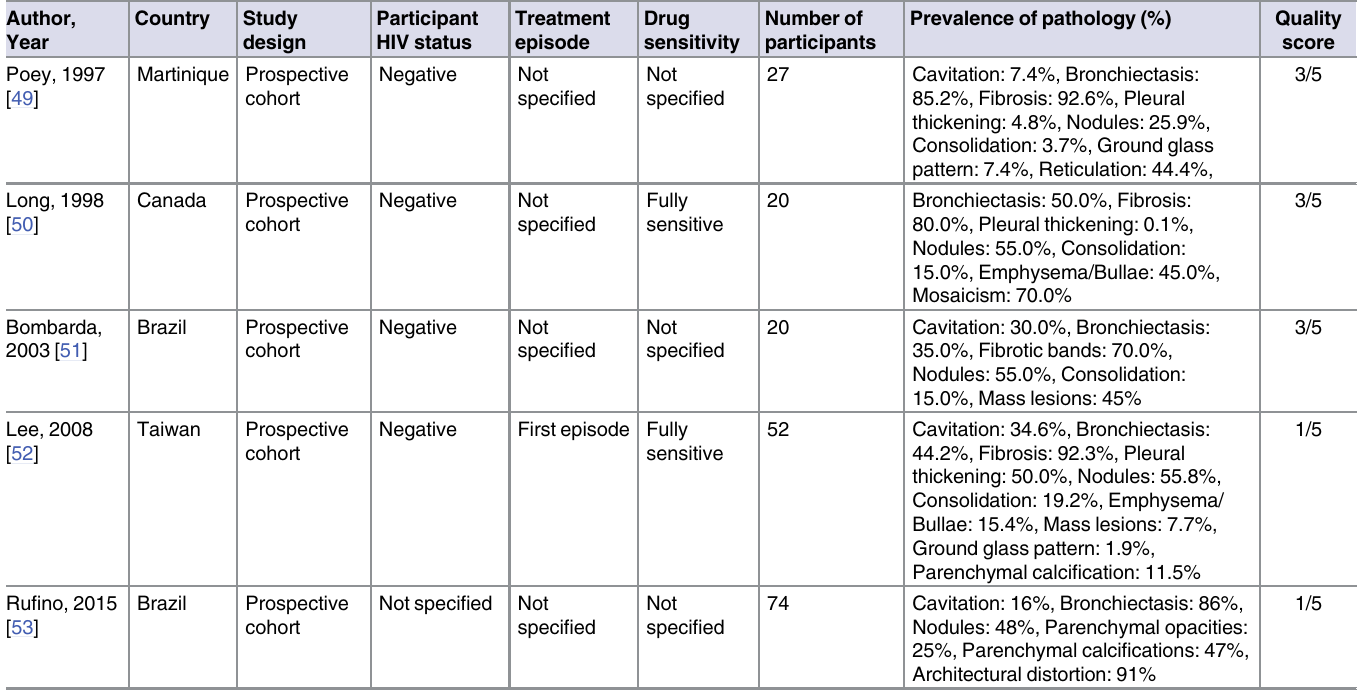
Table 3. Studies reporting prevalence of imaging patterns on CT imaging on completion of treatment for pulmonary